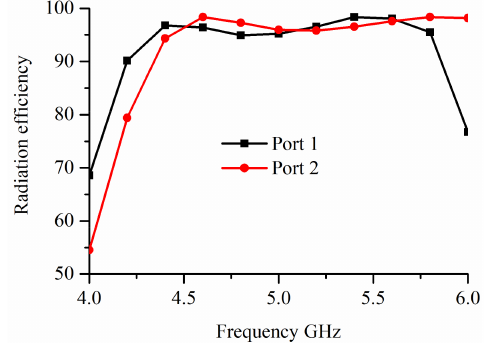
Figure 4. Simulated radiation efficiencies.